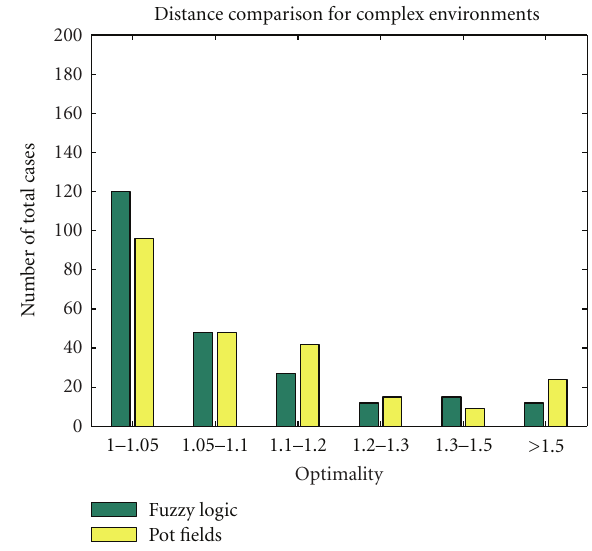
Figure 18: Extra distance traversed for the approximate solutions in moderate (medium density) environments.